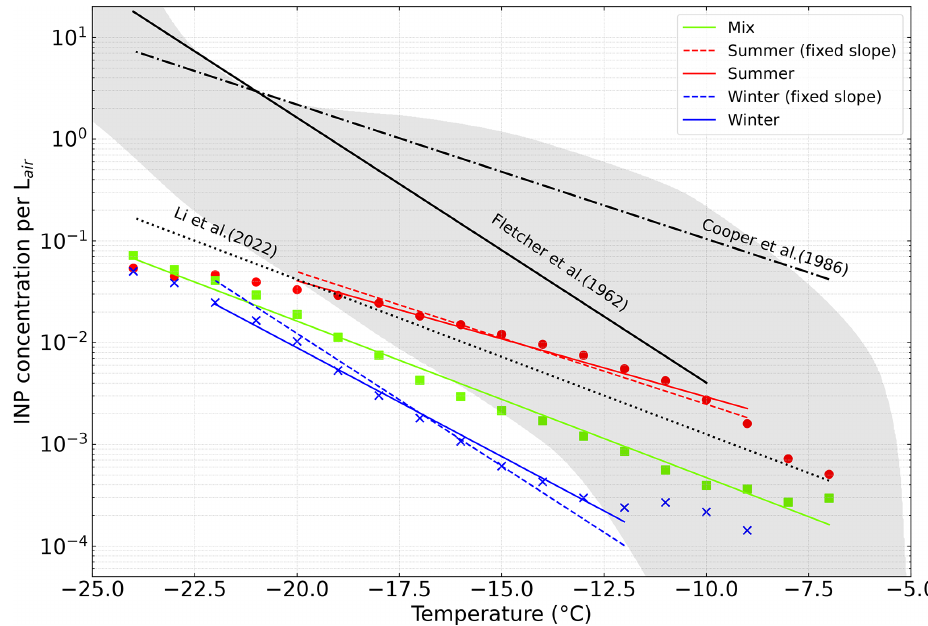
Figure 5. The INP parameterizations for summer, winter and mix type are shown as solid lines in red, blue and light green, respectively. Maxima of the log-normal fits are also shown as dots with the respective colors. For comparison the fixed slope fits (cf. Sect. 3.3) are given as dashed lines of the respective color type. For reference, also the parameterizations by Cooper (1986), Fletcher (1962) and Li et al. (2022) are shown (black lines). Also for reference, the typical range of midlatitude INP concentration according to Petters and Wright (2015) is shown as the gray-shaded area.